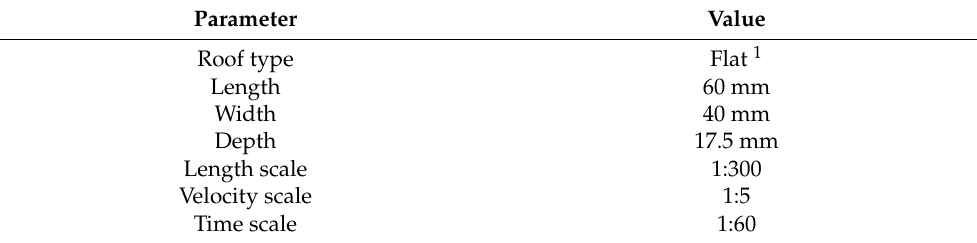
Table 1. Building model parameters.